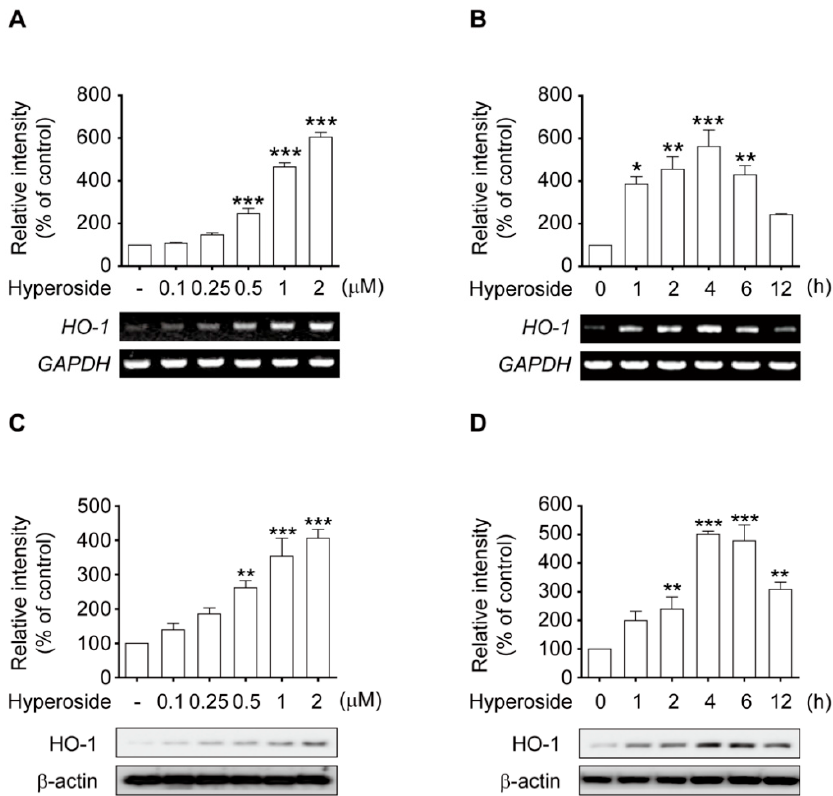
Figure 5. Hyperoside activates Nrf2-mediated HO-1 transcriptional induction in SH-SY5Y cells. Treatment with hyperoside induced the expression of HO-1 in a concentration-dependent manner ( A and C ). Cells were treated with hyperoside (0.1–2 μ M) for 4 h or 6 h, and total mRNA and protein expression was analyzed by RT-PCR and Western blot analysis, respectively. Hyperoside induced the expression of HO-1 in a time-dependent manner ( B and D ). Cells were treated with 2 μ M hyperoside for 0, 1, 2, 4, 6 and 12 h, and the total RNA and protein expression was analyzed by RT-PCR and Western blot analysis. Expression levels of HO-1, β -actin and glyceraldehyde 3-phosphate dehydrogenase (GAPDH) were evaluated by Western blotting and RT-PCR analysis. Error bars indicate the mean ± SEM ( n = 3 ). * p < 0.05, ** p < 0.01, and *** p < 0.001 vs. the control group.